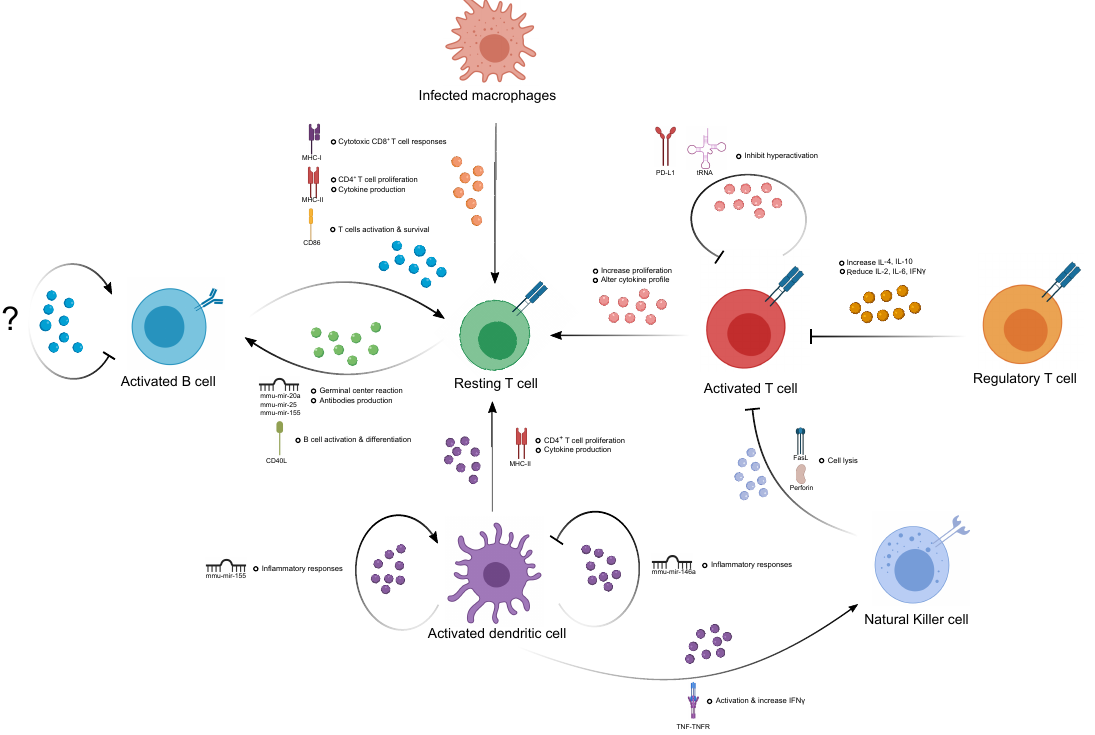
Figure 1. Extracellular vesicle (EV)-mediated immune–immune regulation. This figure depicts the intra- and inter-cellular communications between di ff erent immune cells via the exchange or delivery of the specific EV molecular cargo indicated and how these could exert positive or negative regulatory e ff ects in certain immune